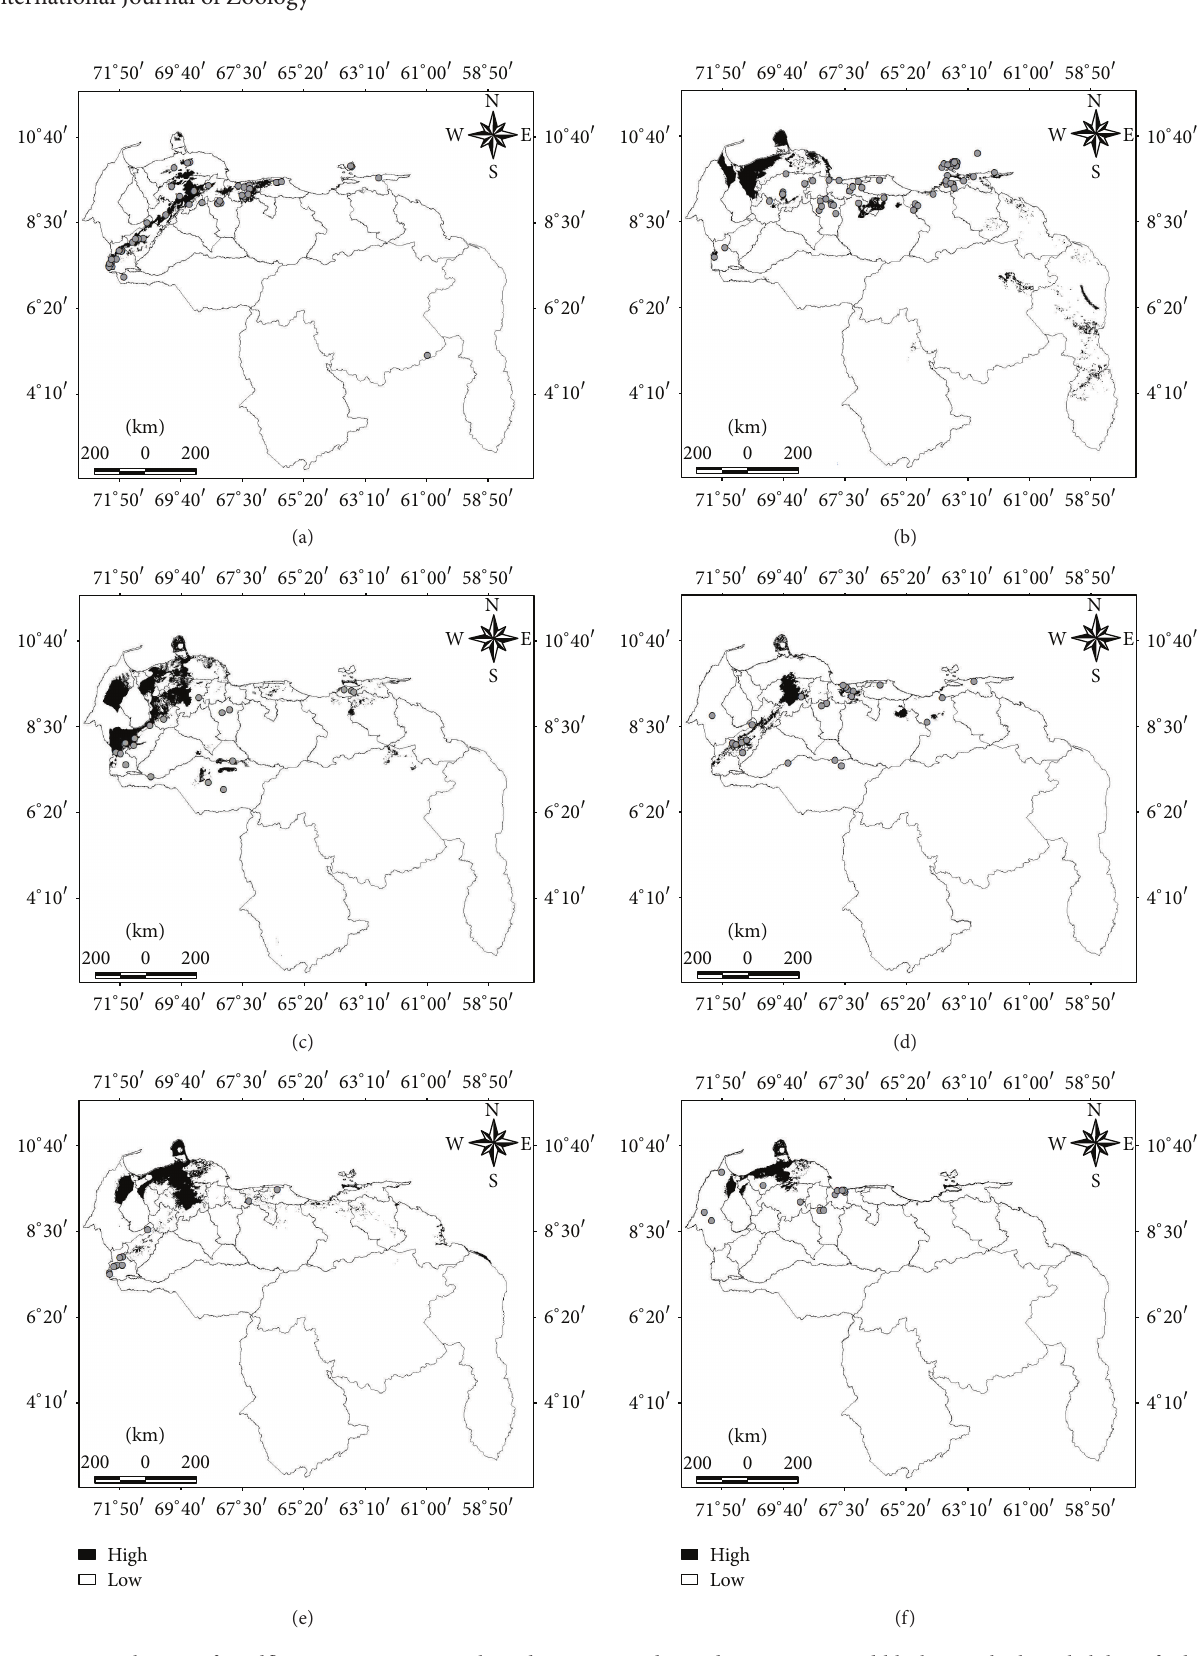
Figure 2: Distribution of sandflies species in Venezuela and gray points denoted occurrences and black areas high probability of relative habitat suitability. Maps are provided for (a) L. lichyi , (b) L. longipalpis s.l. , (c) L. micropyga , (d) L. migonei , (e) L. nuneztovari, and (f)